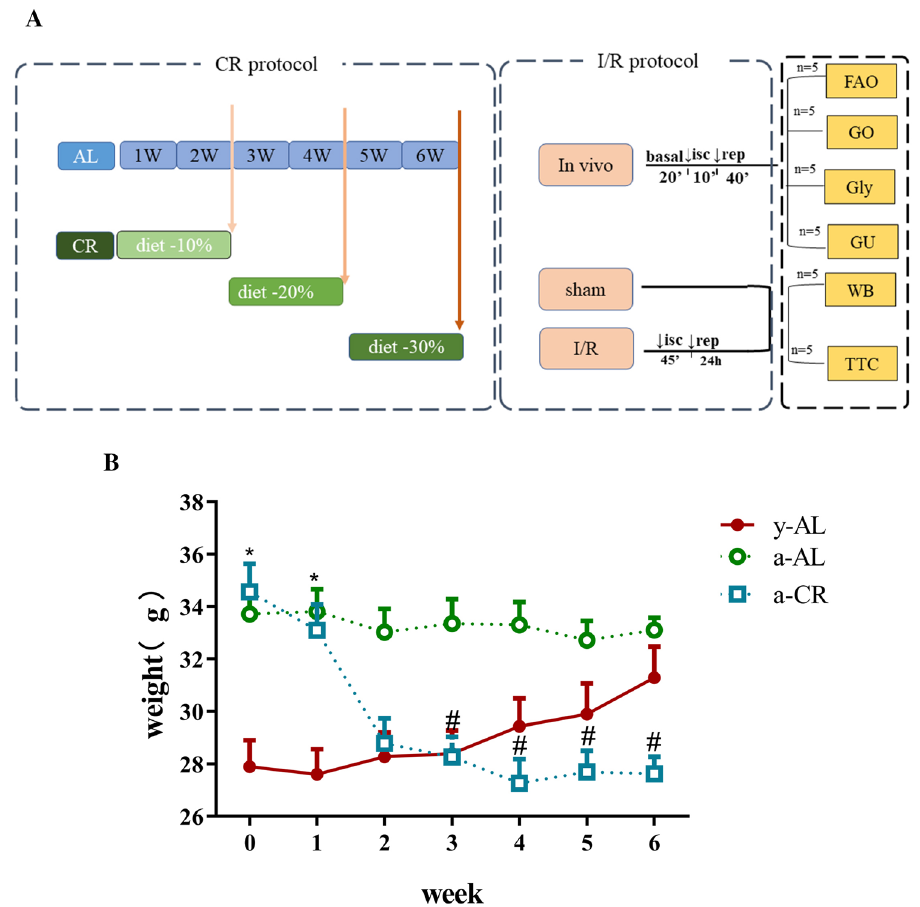
Figure 1. CR decreases mice body weight. ( A ) Experimental design. A 6-week model of caloric restriction CR and a myocardial I/R injury model were established. AL ad libitum, CR caloric restriction, FAO fatty acid oxidation, GO glucose oxidation, Gly glycolysis, GU glucose uptake. ( B ) Body weight changes of mice in each group during 6-week caloric restriction. * P < 0.05 vs y-AL; # P < 0.05 vs